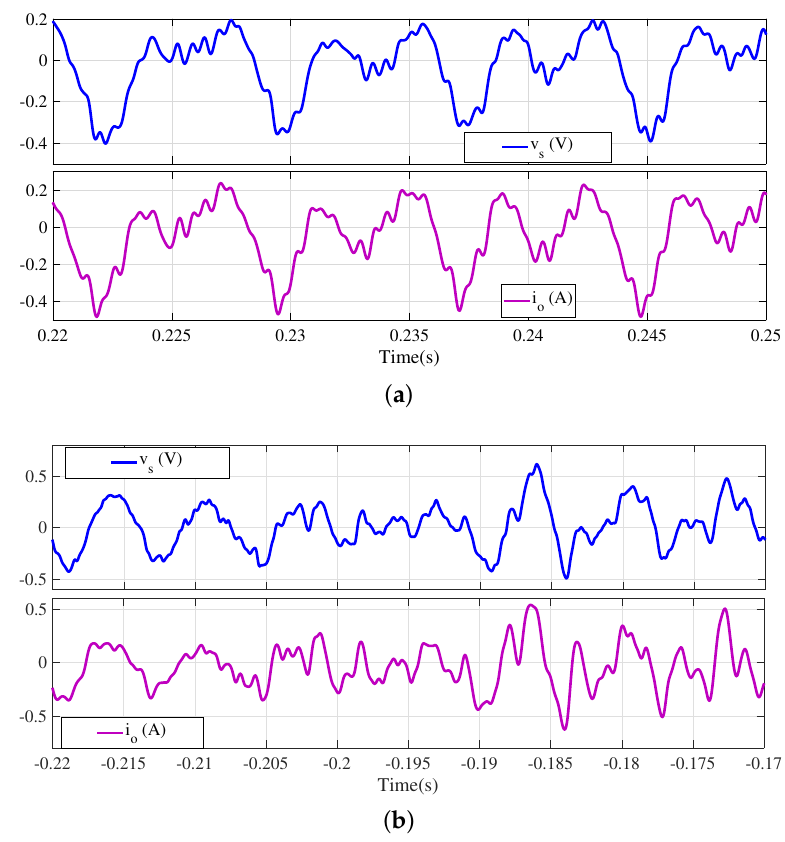
Figure 20. Experimentally obtained v s - i o data. ( a ) Sample 1. ( b ) Sample